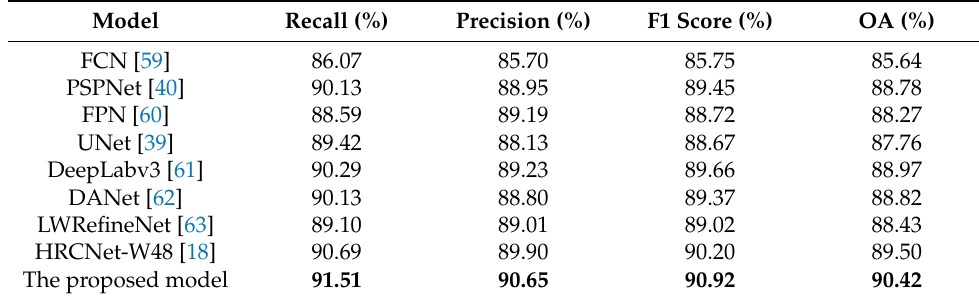
Table 4. Results for the Potsdam dataset using the above